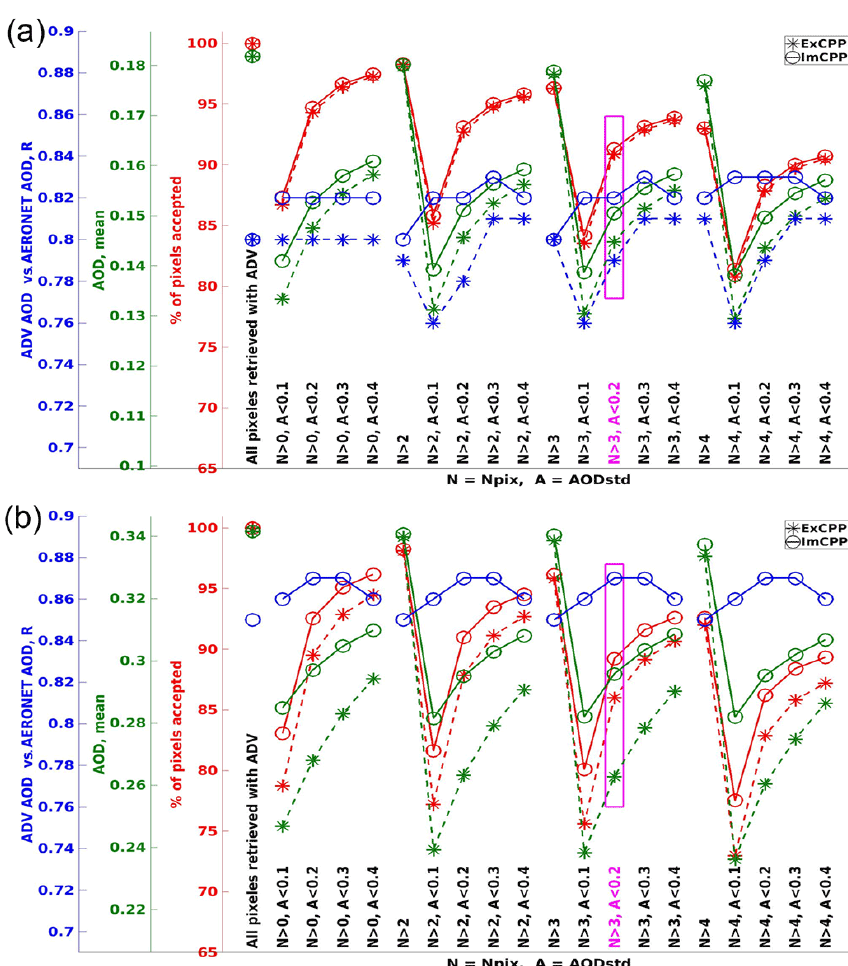
Figure 6. ADV AOD vs. AERONET AOD validation results (blue, R correlation coefficient), AOD yearly means (green), percentage of the pixels accepted from number of all pixels retrieved with ADV (red) for different combinations of Npix ( N ) and AODstd ( A ) thresholds ( x axis) for ExCPP (dashed lines) and ImCPP (solid lines) globally (a) and over China (b) for 2010. The magenta rectangle shows the thresholds selected for ImCPP (based on the combination of better validation results, better coverage and visual inspection, see Sect. 3.2.2 for a more detailed explanation). Note: different scale for AOD mean; for the ExCPP, there are no validation points over